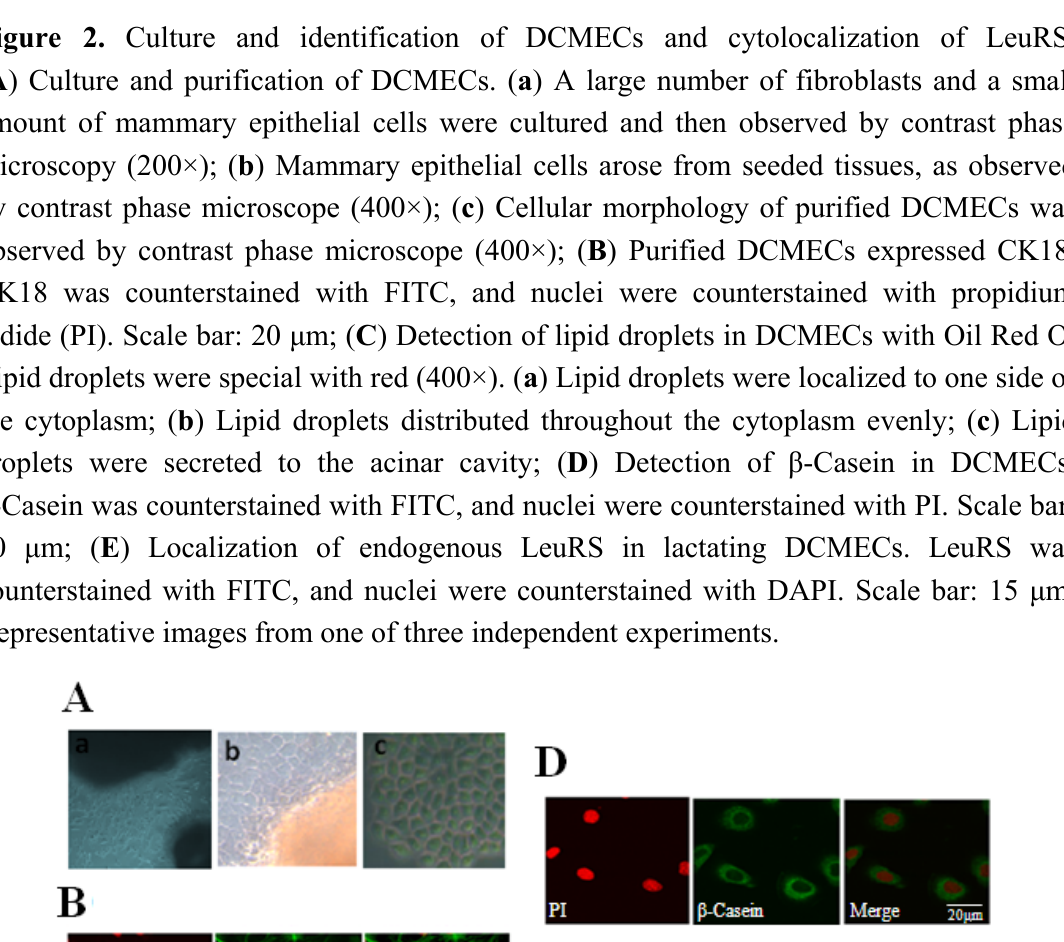
Figure 2. Culture and identification of DCMECs and cytolocalization of